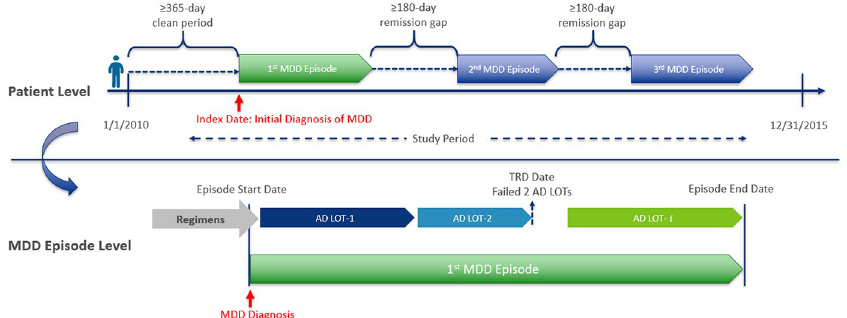
Fig 1. Study design. AD: antidepressant; LOT: line of therapy; MDD: major depressive disorder; TRD: treatment- resistant depression.